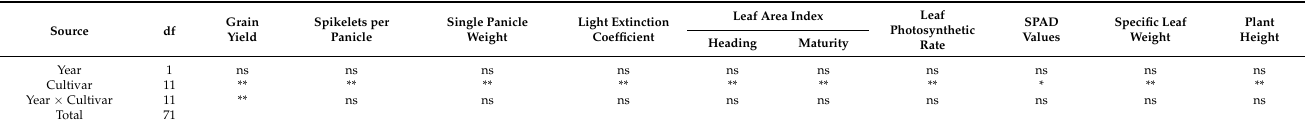
ns, not significant at the 0.05 probability level according to the LSD test; *, significant at the 0.05 probability level according to the LSD test; **, significant at the 0.01 probability level according to the LSD